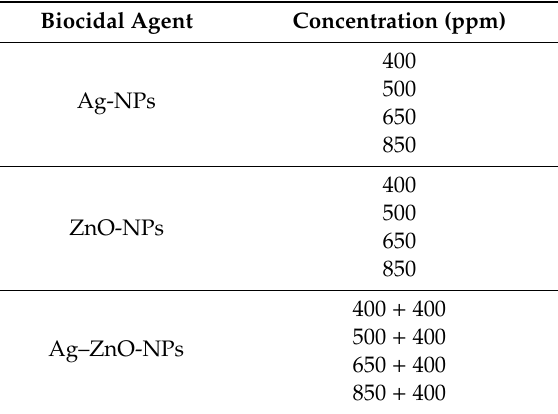
Table 1. Concentration (ppm) on nanoparticle-containing polyester surfaces for the study of antimicrobial